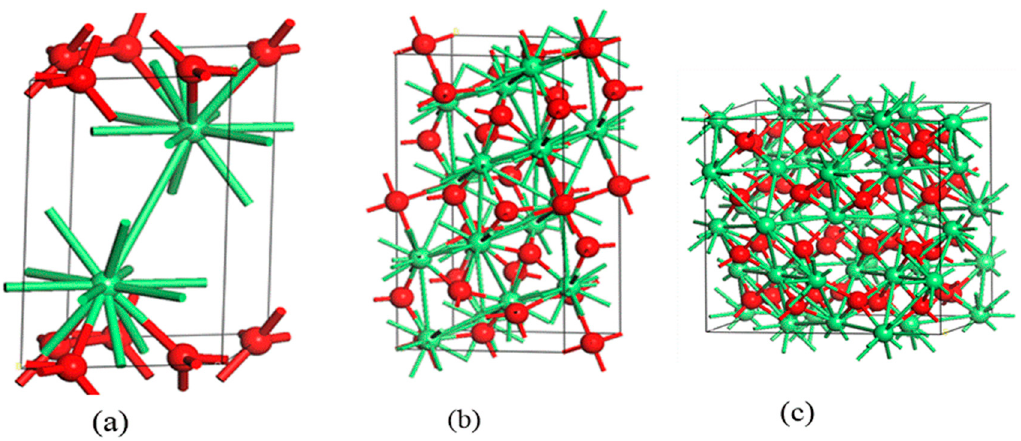
Figure 1. Unit cells of Ln 2 O 3 : ( a ) A-type (hexagonal), ( b ) B-type (monoclinic), and ( c ) C-type (cubic).